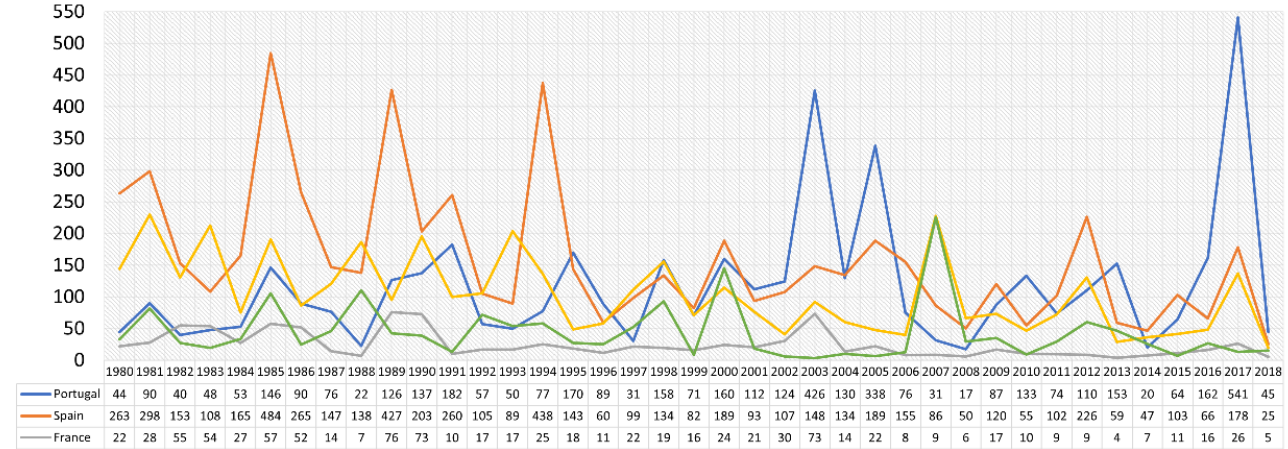
Figure A1. Total burned area (kha) between 1980 and 2018 for Portugal, Spain, France, Italy, and Greece (Data retrieved from EEA, https://www.eea.europa.eu/ims/forest-fires-in-europe accessed on 1 February 2022).